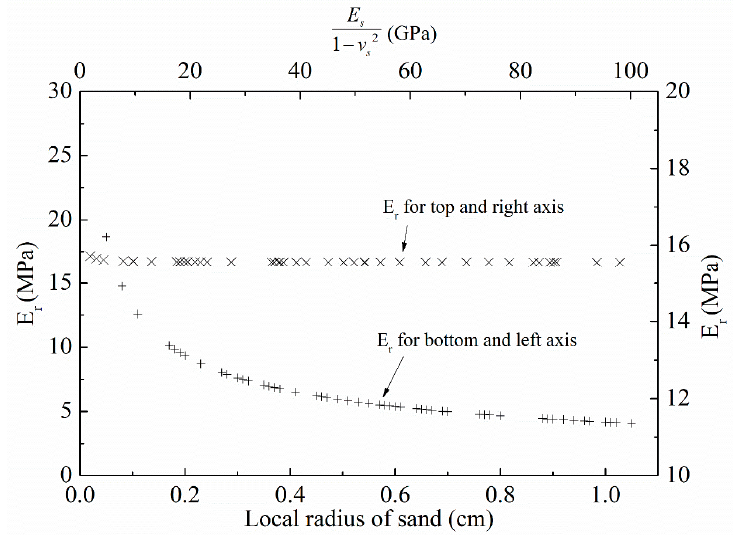
Figure 19. Sensitivity analysis of Hertz model in the estimation of the Young’s modulus of rubber ( E r ).